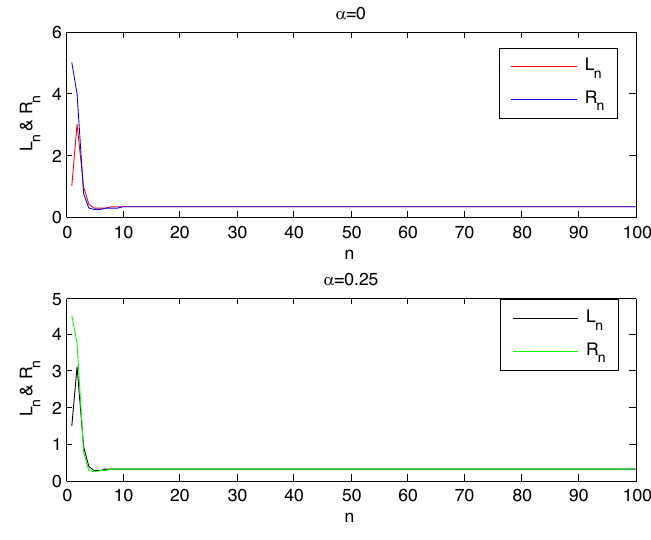
Figure 5: The solution of system ( 48 ) at = α 0 and = α 0.25